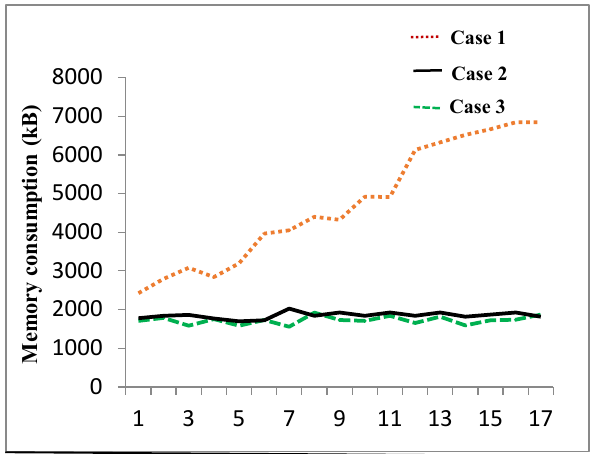
Figure 11 . used amount of the memory in the context manager processes